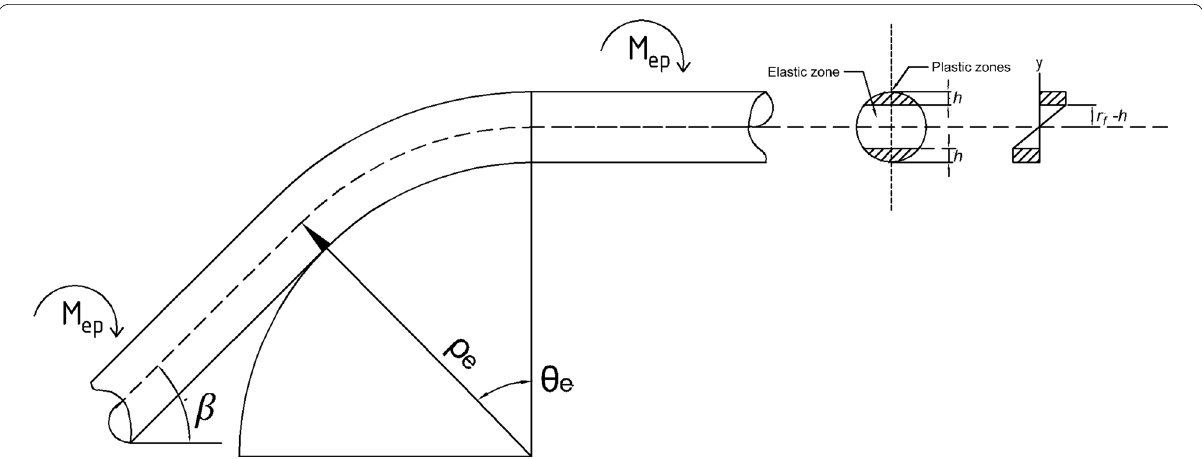
Fig. 13 Curvature for elastic–plastic bending.